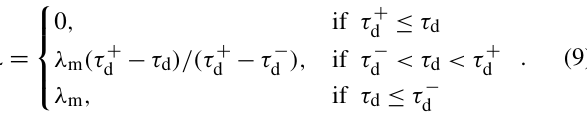
= 60kPa, τ + = 110kPa, and λ m = 0 . d d